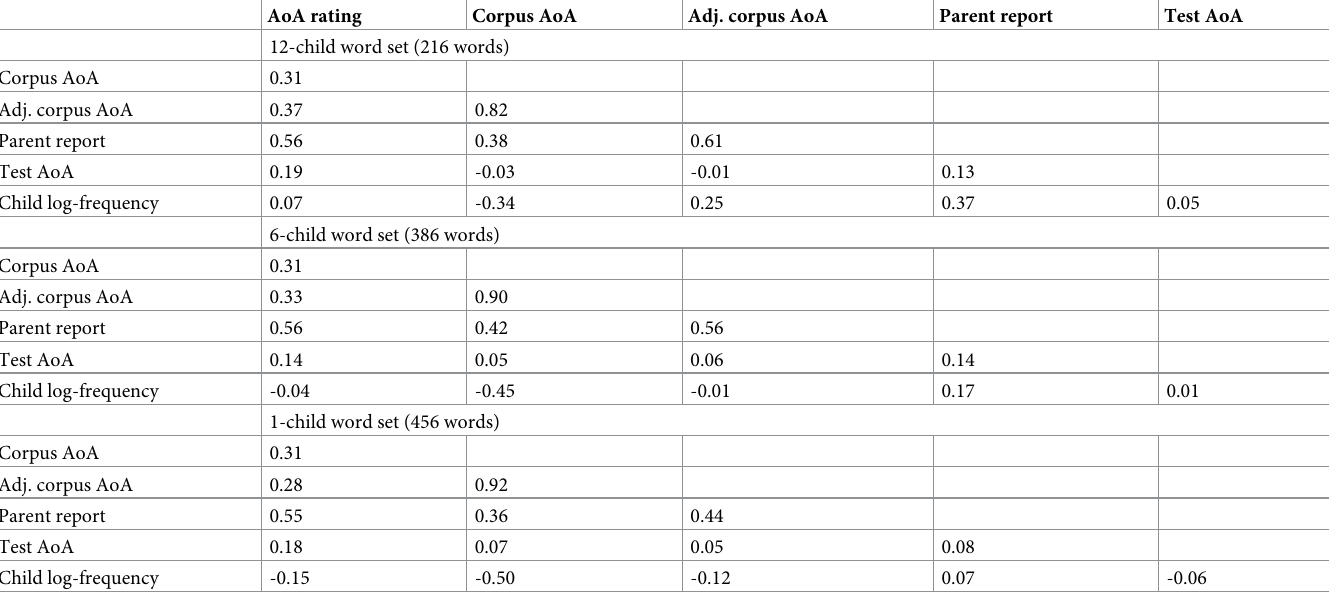
Table 2. Correlations between parent-report AoA, raw and adjusted corpus AoA, and adult AoA